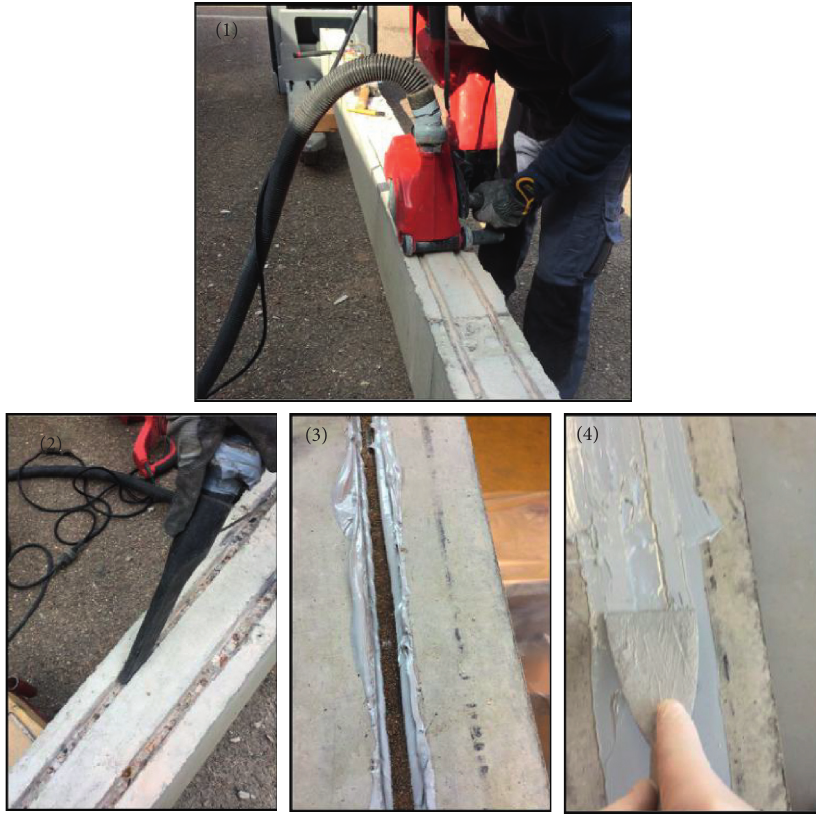
Figure 6: The procedure of NSM FRP